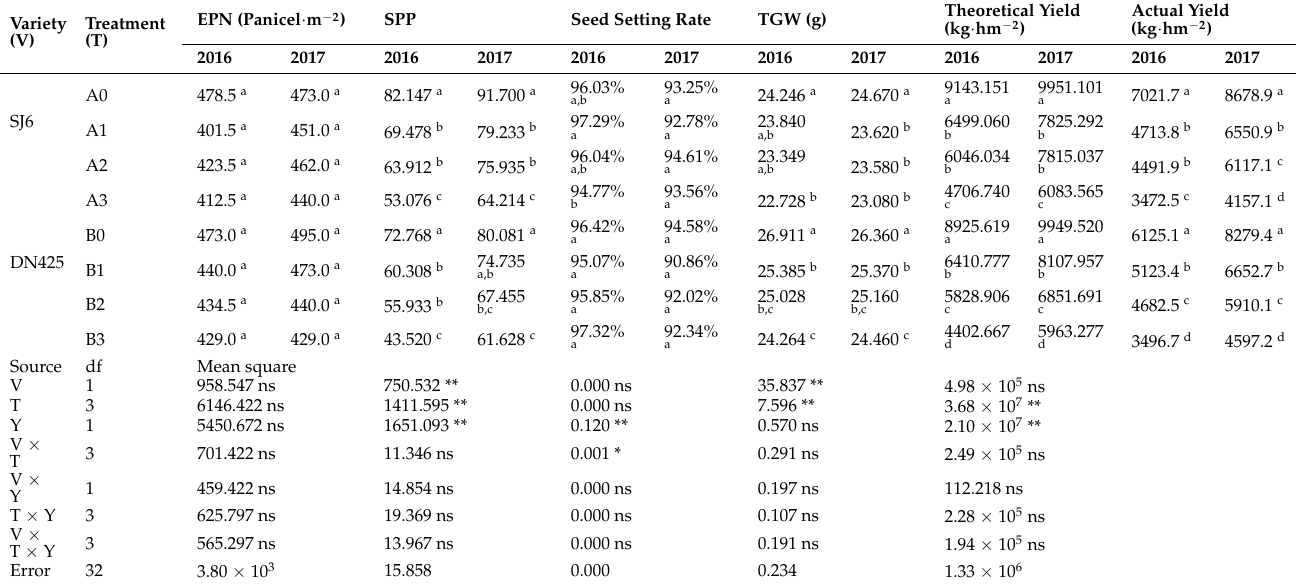
Table 4. Effects of drought stress at the jointing–booting stage on the yield and its composition of growth period overlapping rice in 2016 and